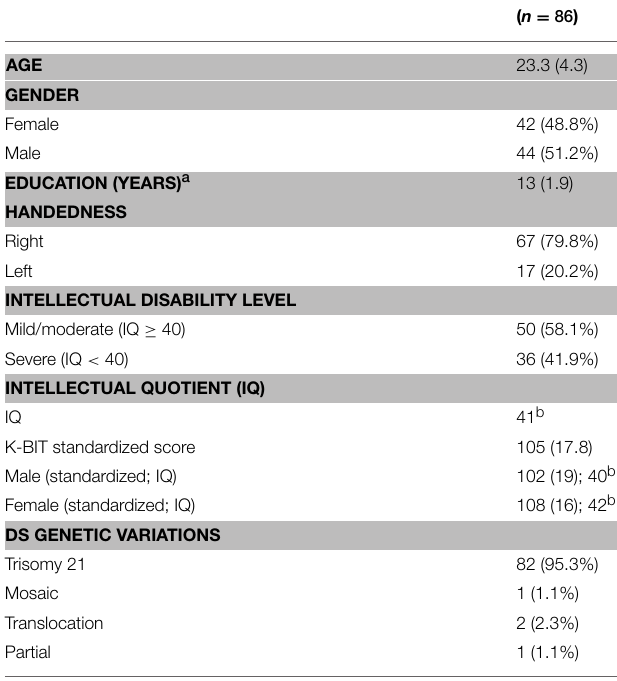
Resultsarepresentedasmean(standarddeviation)forcontinuousvariablesandabsolute frequency (relative frequency) for categorical variables. a Average years of school attendance in specialized or non-specialized educational centers. b Only the median is reported because values below 40 cannot be determined